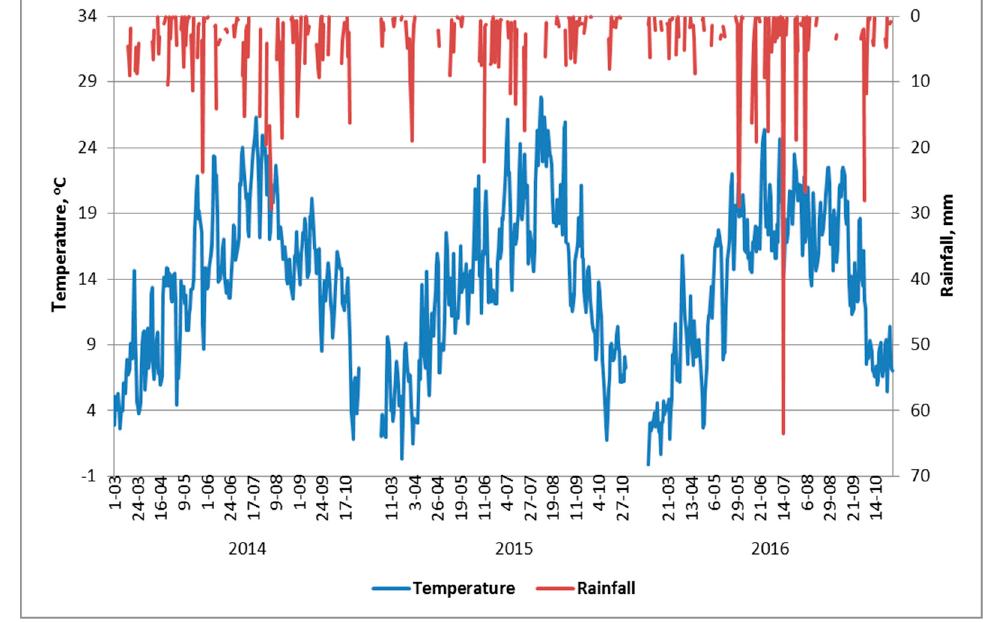
Figure 1. Mean daily air temperature and precipitation during the 2014–2016 growing seasons of maize. Table 3. Effect of digestate application method and rate on grain yield and maize yield components in consecutive years of study.